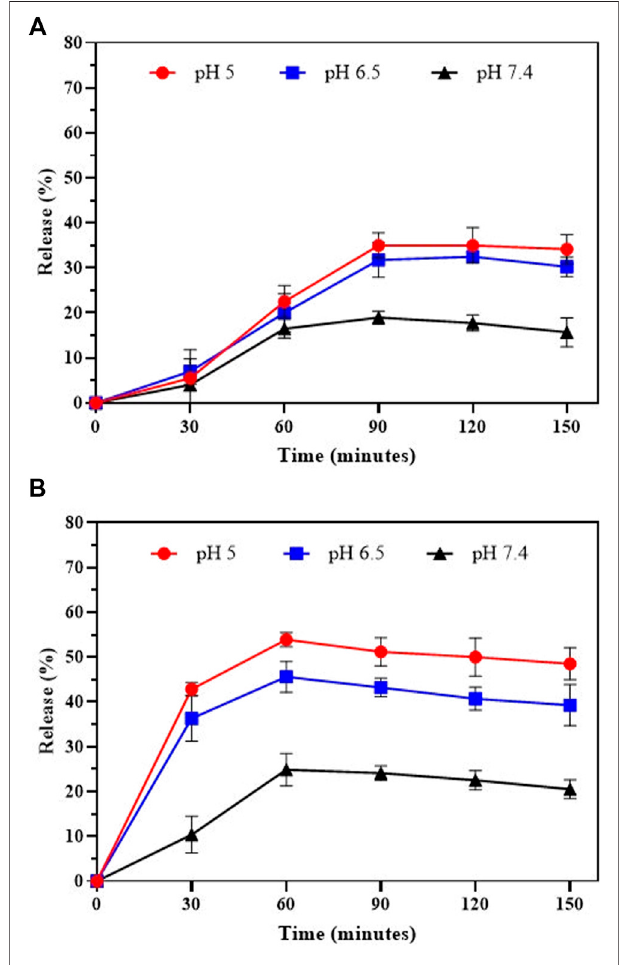
FIGURE 3 | In-vitro drug release of (A) Prodigiosin and (B) Simvastatin from Ca-Gly-Maltose in PBS at pH 5, 6.5 and 7.4.